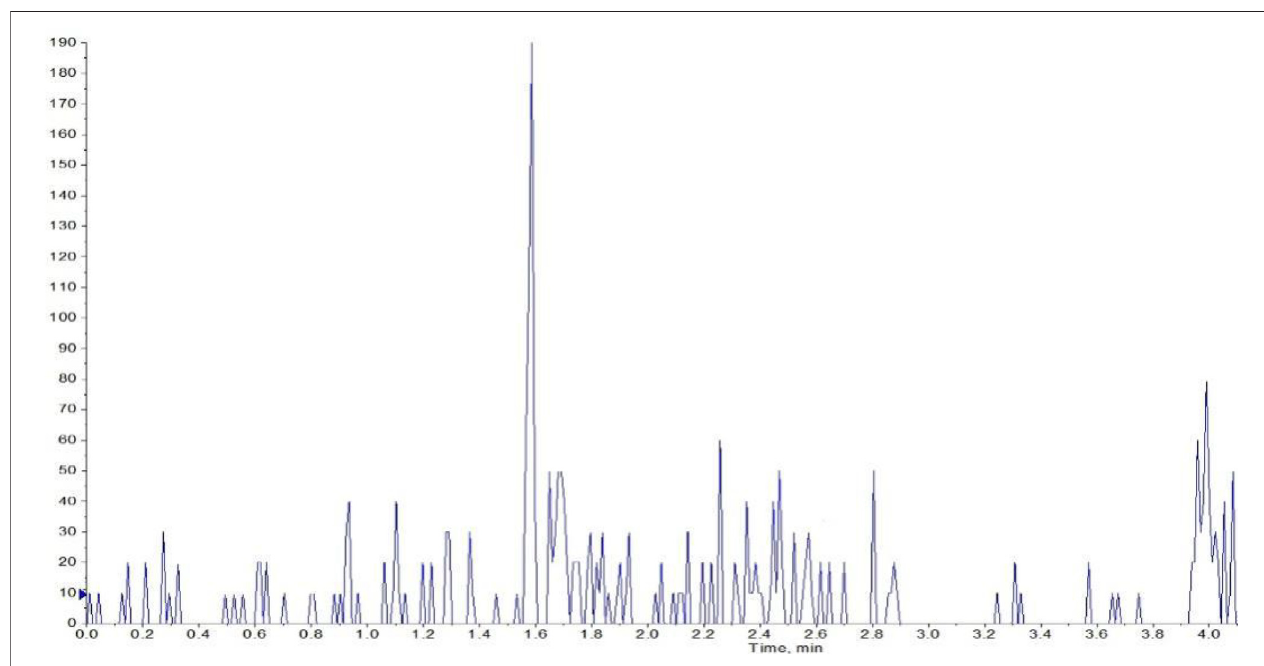
FIGURE 6 | Chromatographic pro fi le of the plasma of control mouse.